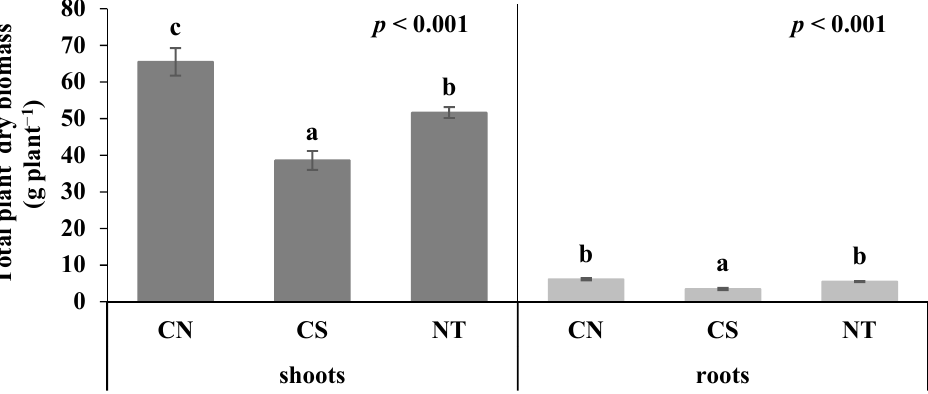
Figure 3. Soybean shoot and root production according to the different tillage systems (CN, conventional; CS, conservation; NT, no-tillage). Data are the means ± standard error. Different letters (a, b, c) indicate significant differences ( p ≤ 0.05, Tukey’s tests) among treatments.